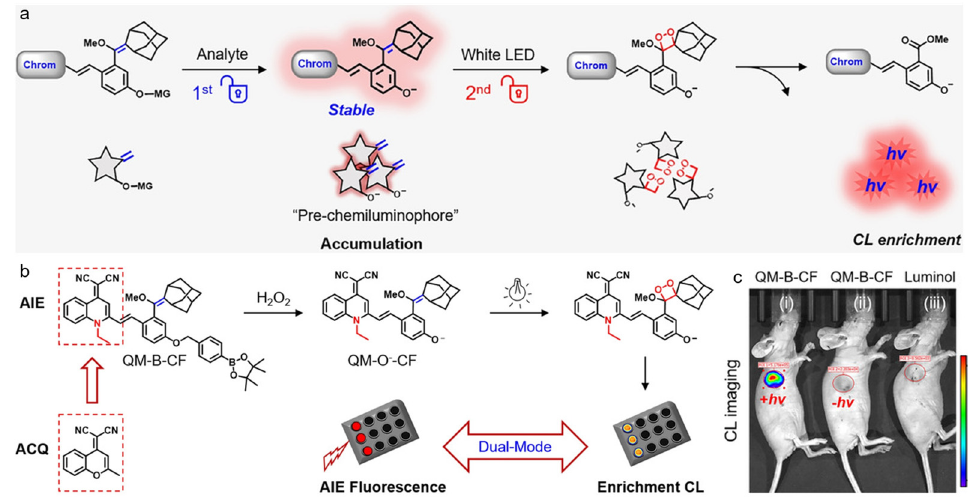
Figure 8. ( a ) Schematic of the dual-lock probe triggered sequentially by analyte and light for CL imaging; ( b ) the reaction processes of AIE-based dual-lock probe QM-B-CF; ( c ) in vivo imaging of 4T1 xenograft tumor-bearing mice after intratumor injection of QM-B-CF or luminol. (Reproduced with the permission from ref. [134]. Copyright 2020, Wiley-VCH Verlag GmbH & Co. KGaA, Wein- heim).